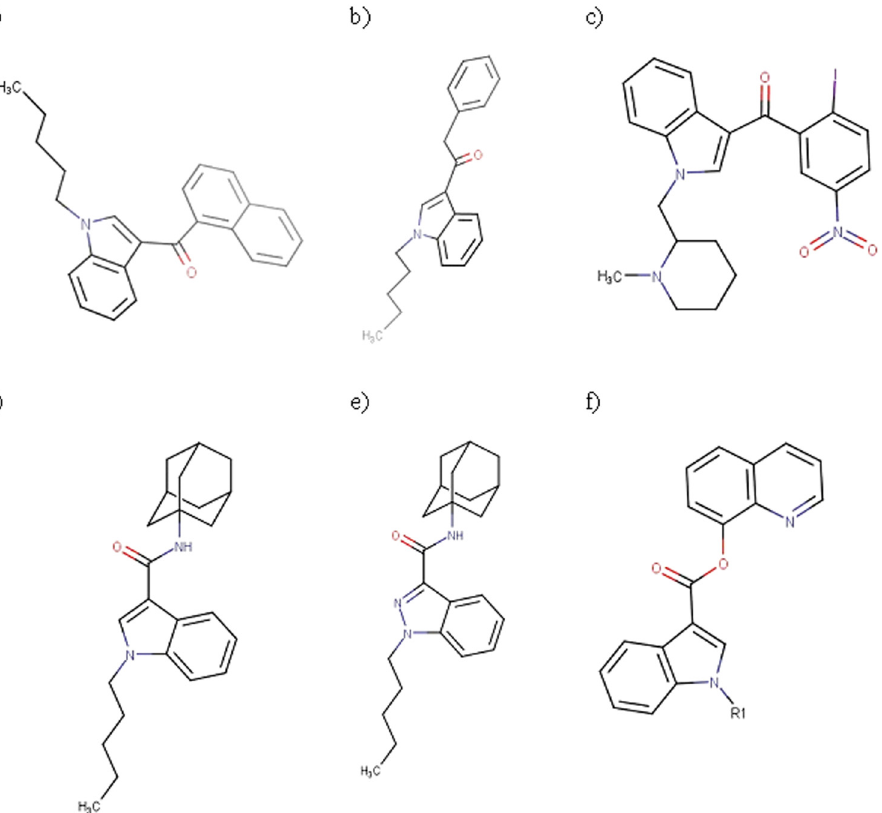
Figure 2: Sample structures for synthetic cannabinoids: ( a ) JWH - 018, a simple naphthoylindole; ( b ) JWH - 167, a simple phenylacetylindole; ( c ) AM - 1241, a chemical from benzoylindole family; ( d ) APICA ( 2NE1, SDB - 001 ) , a drug from adamantylindole group; ( e ) APINACA ( AKB48 ) , a drug from adamantylindazoles family; ( f ) general structure for